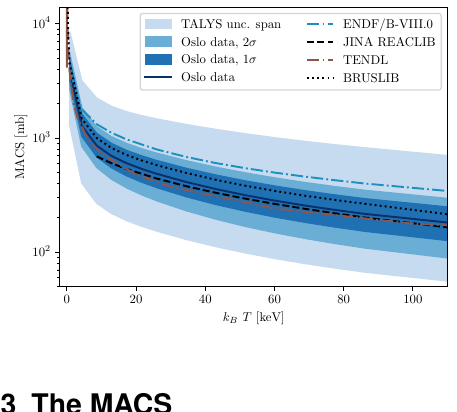
Figure 2. The constrained MACS uncertainty for the ( n ,γ ) 127 Sb reaction, compared to the uncertainty range from combining all the NLD and GSF theoretical models from